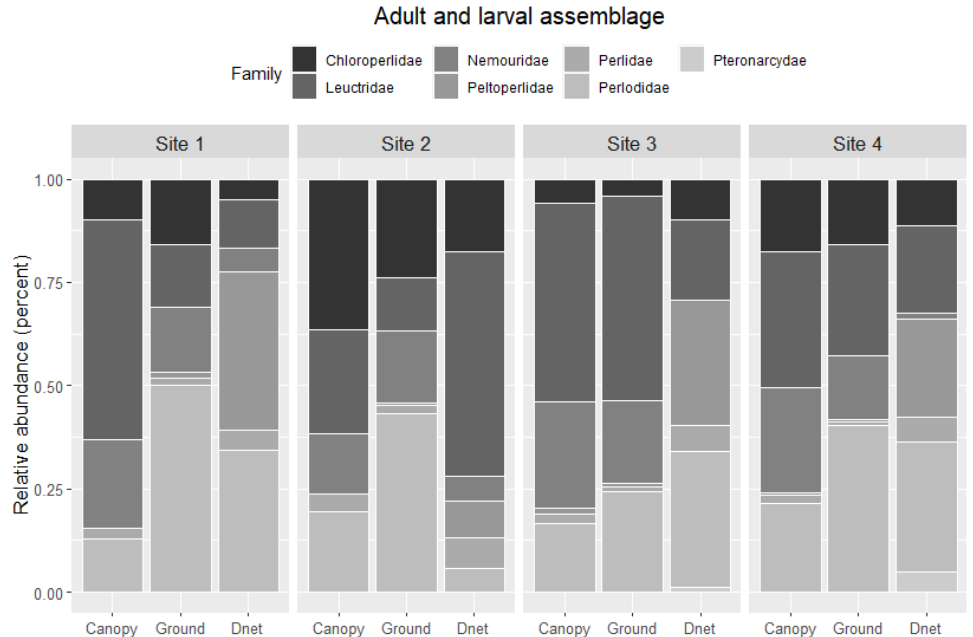
Figure 9. Stacked bar chart representing relative abundance and assemblage composition at each site for adult plecopteran taxa in ground and canopy traps and larval plecopteran taxa in benthic samples. Abundances for ground and canopy traps from summer and autumn samples are combined for this analysis.